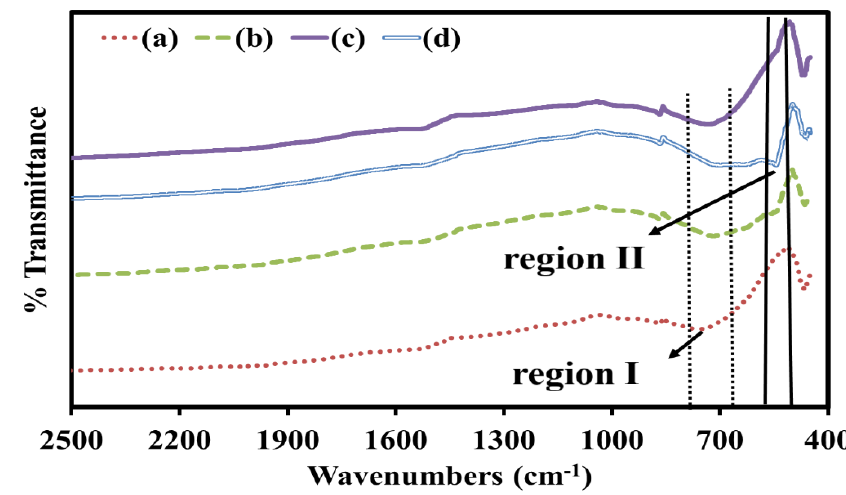
Figure 5. FTIR spectra of ( a ) STC, ( b ) STCM3, ( c ) STCM5, and ( d ) STCM7.